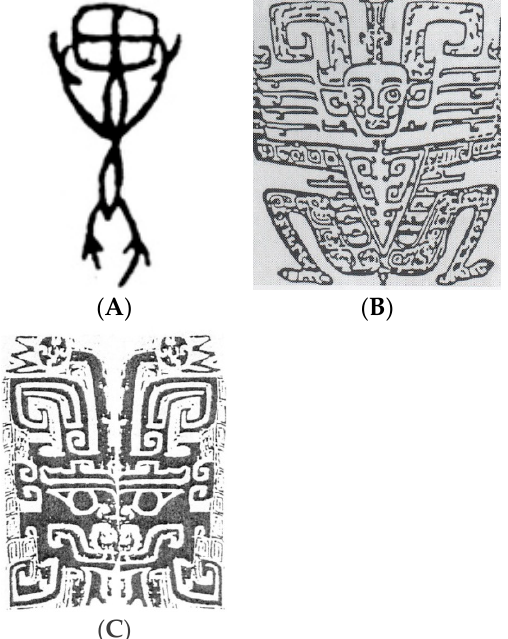
Figure 1. Masked semi-human figures with arms raised. ( A ) Yi 異 graph; ( B ) Displayed yi image, probably Kui; ( C ) Simplified displayed yi image.